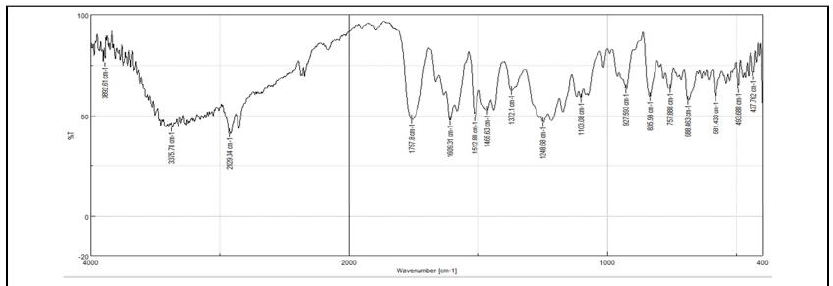
Fig. 5. FT-IR spectrum of PE polyester